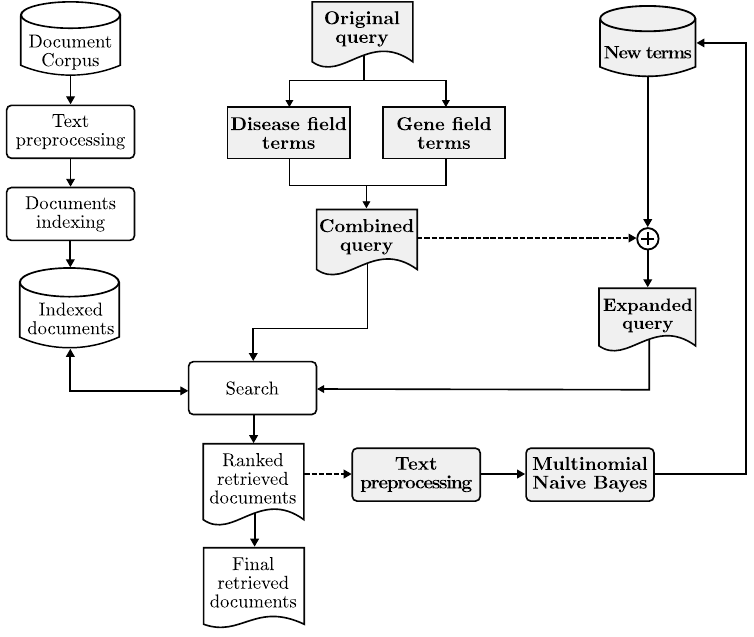
Figure 4. The proposed